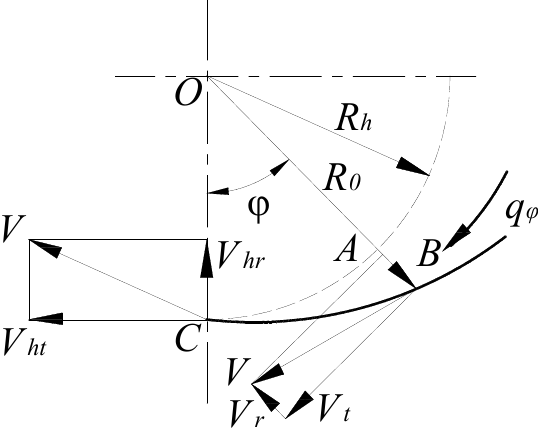
Figure 5. Analyses of the motion of airflow in the volute.